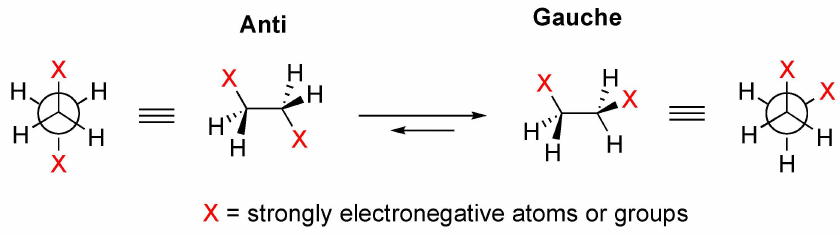
Figure 1. The gauche effect in 1,2-difluoro- and